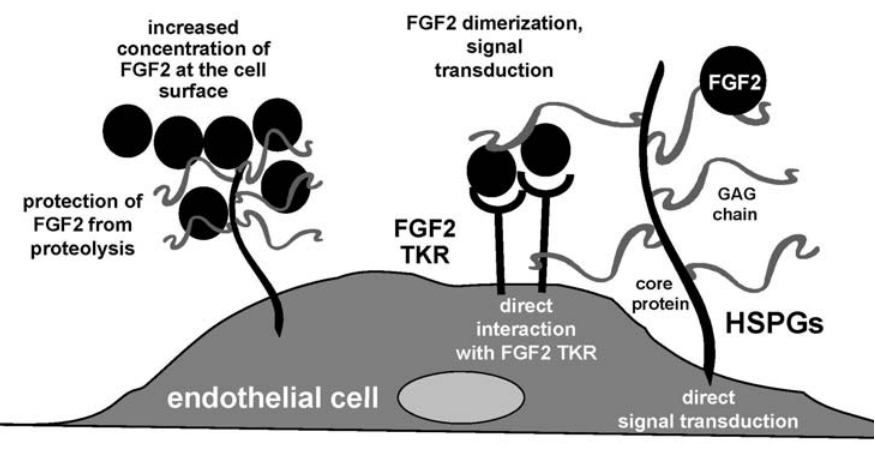
Figure 3. Schematic representation of the biological functions of HSPGs in FGF2